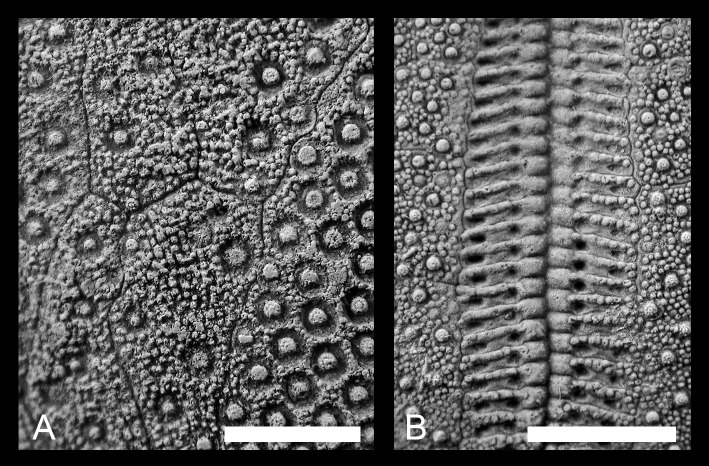
Development in the structure of periplastronal area and the interporiferous area of the paired petals.(A) Granular periplastronal area (MB.E.8196, Liencres, Spain). (B) Subdivided interporiferous area of the paired petals (GSUB E3867, Erwitte area, Germany). Scale bars equal 0.5 cm.